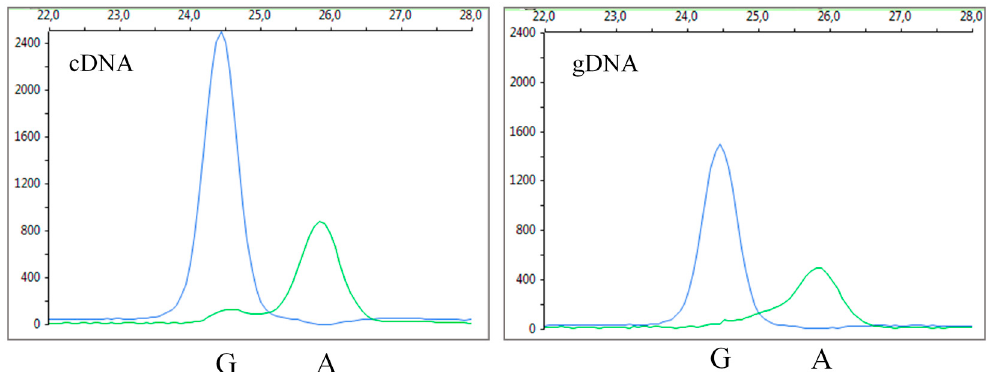
Figure 2. There is no evidence of allelic imbalance associated with CLSPN c.1574A > G in HeLa cells. Electropherograms depicting fluorescence peaks obtained from HeLa cDNA (left panel) and gDNA (right panel) primer extension analysis. Allelic variants are labelled at the bottom of their corresponding peak. X axis: size in base pairs; Y axis: fluorescence intensity. The average of the normalized ratio cDNA (WT / Mut) / gDNA (WT / Mut) obtained was 0.9 ± 0.1, which is indicative of no AI.